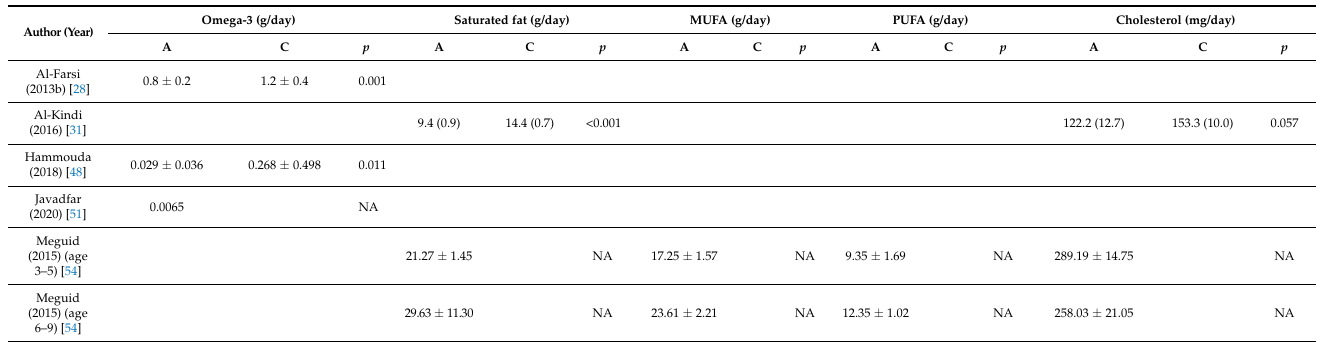
Table 6. Dietary fat intake data of ASD-C and controls in the MENA